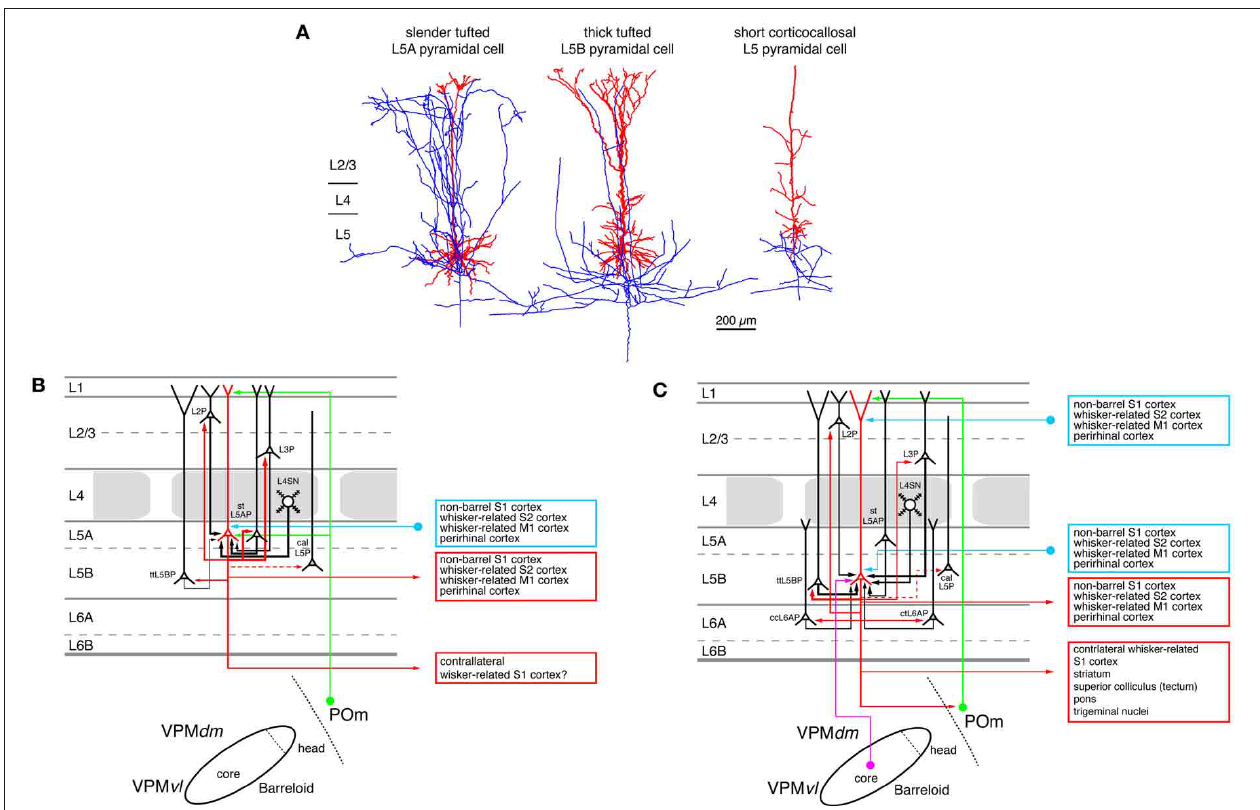
FIGURE 6 | Excitatory synaptic input–output relationship in layer 5 of the S1 barrel cortex. (A) Reconstructions of three types of pyramidal cells in layer 5 of the barrel cortex. Slender-tufted pyramidal cells (left) are predominantly located in sublamina 5A (Feldmeyer et al., 2005) while thick-tufted pyramidal cells (middle) are mostly found in sublamina 5B (Lübke and Feldmeyer, 2007). Corticocallosal L5 pyramidal cells (right) are found throughout layer 5. They are characterized by a very diminutive or even absent apical tuft (Le Bé et al., 2007). Modified with permission of the Society of Neuroscience, Springer and Oxford Journals, respectively. (B) Diagram of the excitatory synaptic connections of and onto slender-tufted L5A pyramidal cells (red neuron with blue axon) in the barrel cortex. Only synaptic input from